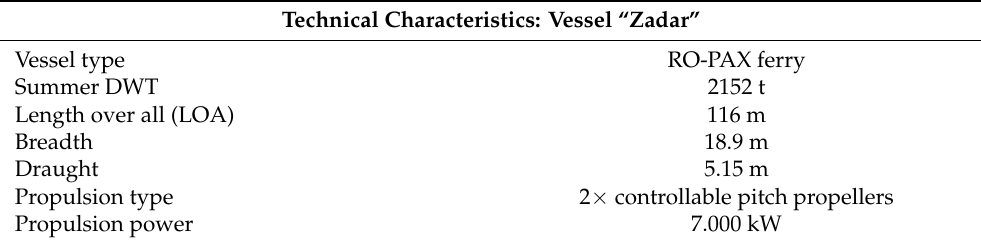
Table 10. Technical characteristics of the reference vessel “Zadar”. Technical Characteristics: Vessel “Zadar”